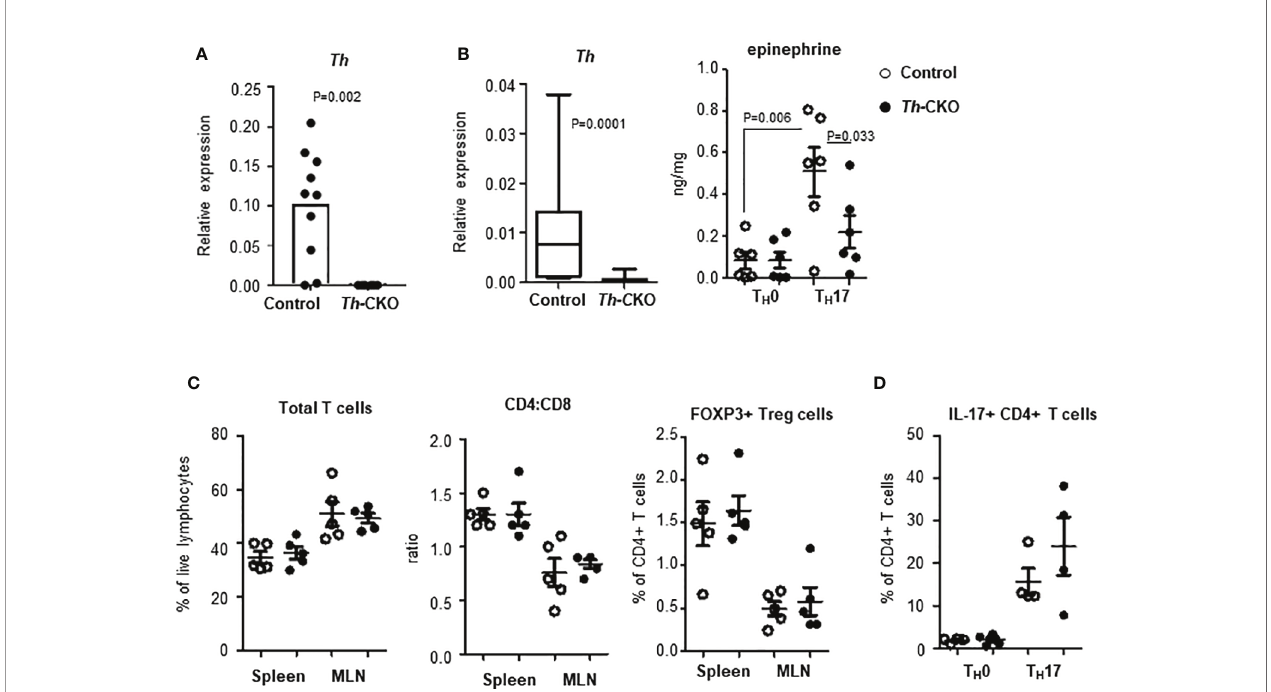
FIGURE 5 | Epinephrine expression and lymphocytes in Th-CKO mice. (A) T H 17 cells were isolated from SCs from control and Th-CKO EAE mice and Th expression was measured by qPCR. The relative expression was calculated to the level of Porl2a . Each dot represents an individual animal. 3 independent experiments (n = 6). (B) Naïve CD4+ T cells were isolated from spleens of 6-8 weeks old control and Th-CKO mice and differentiated into T H 0 or T H 17 cells. Total RNA was prepared and Th expression was measured by qPCR. The relative expression was calculated to the level of Porl2a . Box-and-Whisker plot, horizontal bars indicate the median, boxes indicate 25 th to 75 th percentile, and the whiskers indicate 10 th and 90th percentile. Three independent experiments (n = 6). Cells were washed with PBS and epinephrine was measured by mass-spectrometry. Each dot represents and individual sample and the bar represents the mean ± SEM (n = 3). T lymphocytes in spleen and MLN of control and Th-CKO mice were characterized by fl ow. (C) Total TCR b + T cells, CD4+ T cells, CD8+ T cells, and FOXP3 + Treg cells were measured by fl ow cytometry. (D) T H 17 cells were differentiated from naïve CD4+ T cells of control and Th-CKO mice and IL-17a-positive CD4+ T cells were quanti fi ed. Each dot representative of individual mouse and the bar represents the mean ± SEM (n =